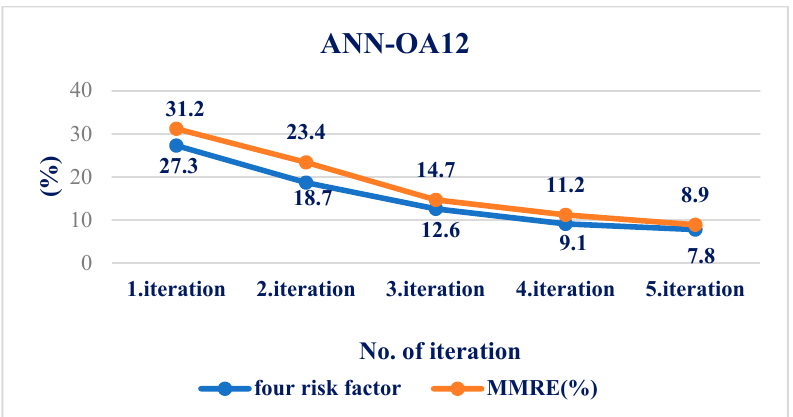
Figure 8. Influence of four factors on the resulting risk and error of the ANN-OA12 model through five iterations.